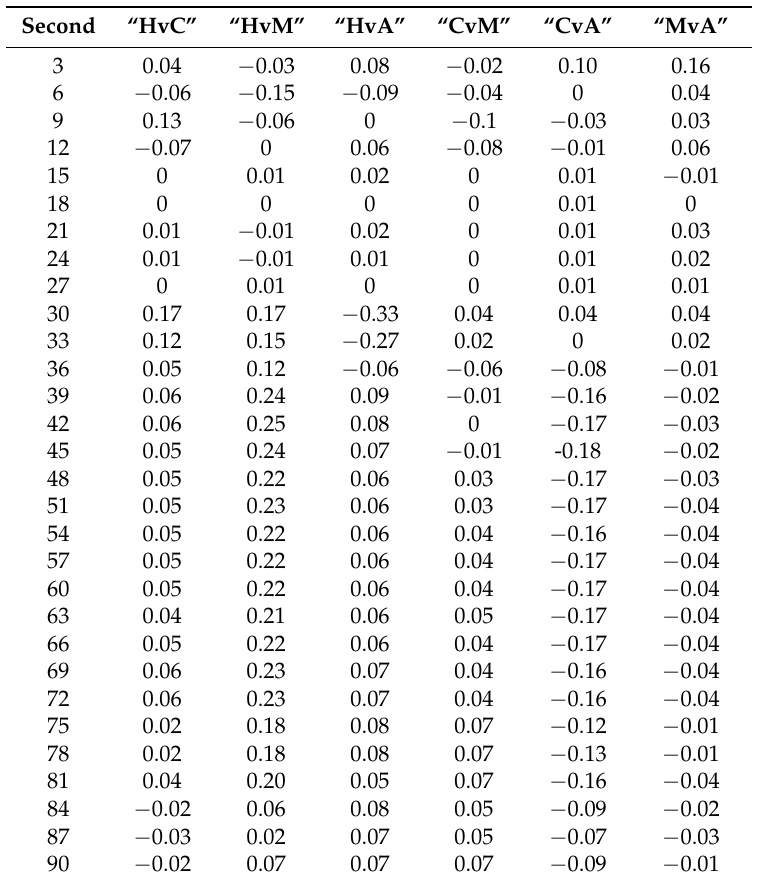
Table 2. Interaction indices for each pair of panel descriptive attributes to Overall Liking of Texture varying with time